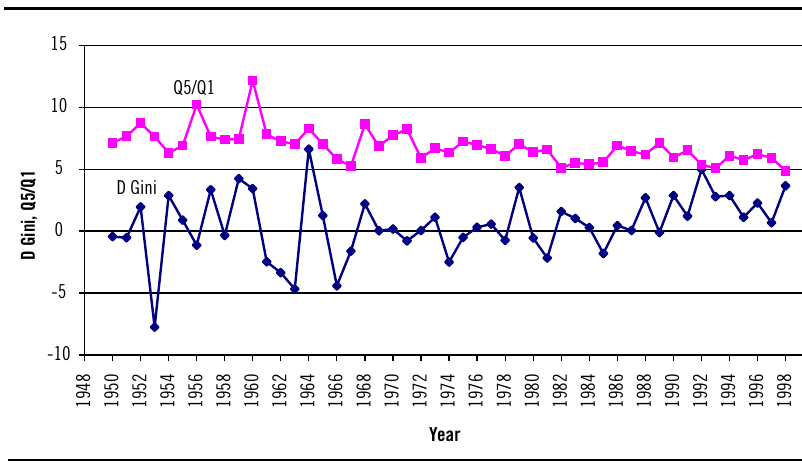
Figure 3 – Development of Changes in the Global Gini Coefficient and Q5/Q1